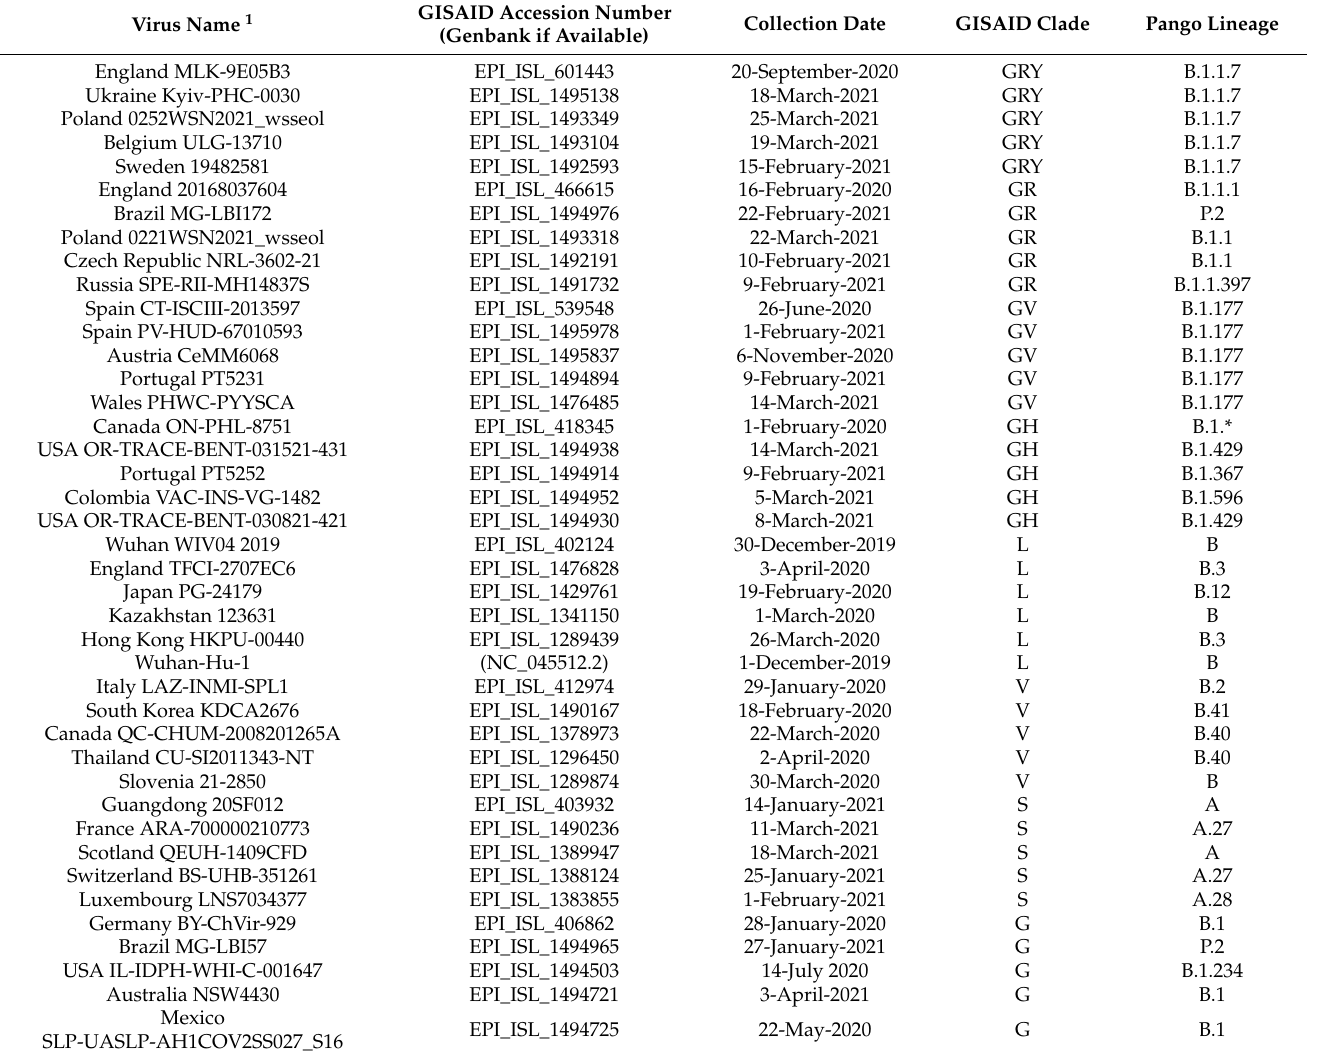
Table 2. Randomly selected strains from each GISAID